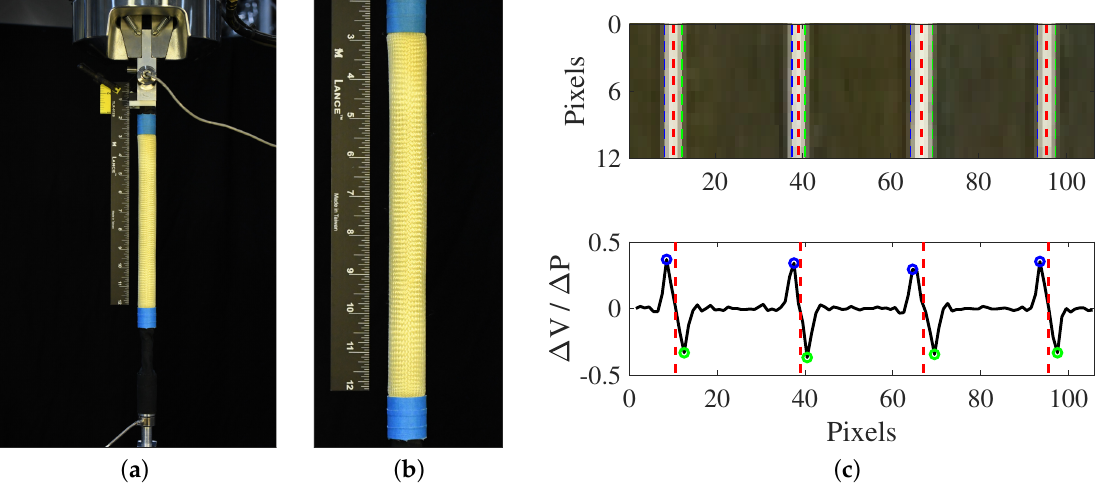
Figure 8. Method of image scale calibration using ruler: ( a ) Original image view (5569 × 3712 pixels). ( b ) Cropped image view (2650 × 1100 pixels). ( c ) Identification of ruler 1/8in increment hatch marks. ( Top ) Each hatch mark has its left (blue), right (green), and then center (red) located. ( Bottom ) Locating respective points of each hatch mark is performed through analysis of the brightness ( V )